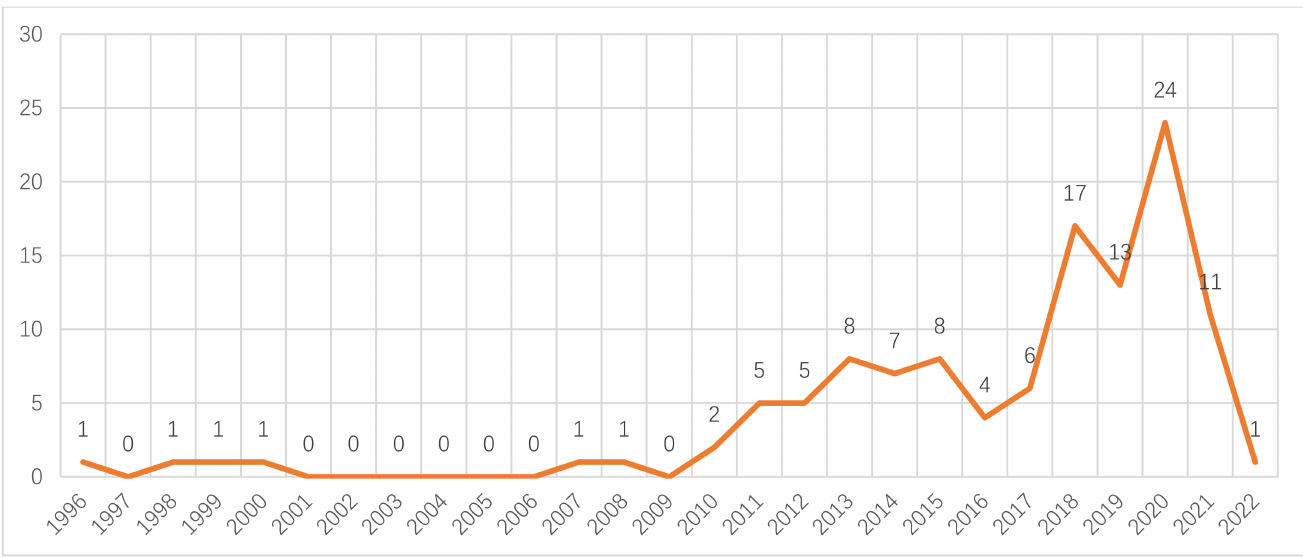
Figure 2. The number of articles on the theme of “social mentality” and “health” in the China National Knowledge Infrastructure (CNKI) database before 1 April 2022 (generated by